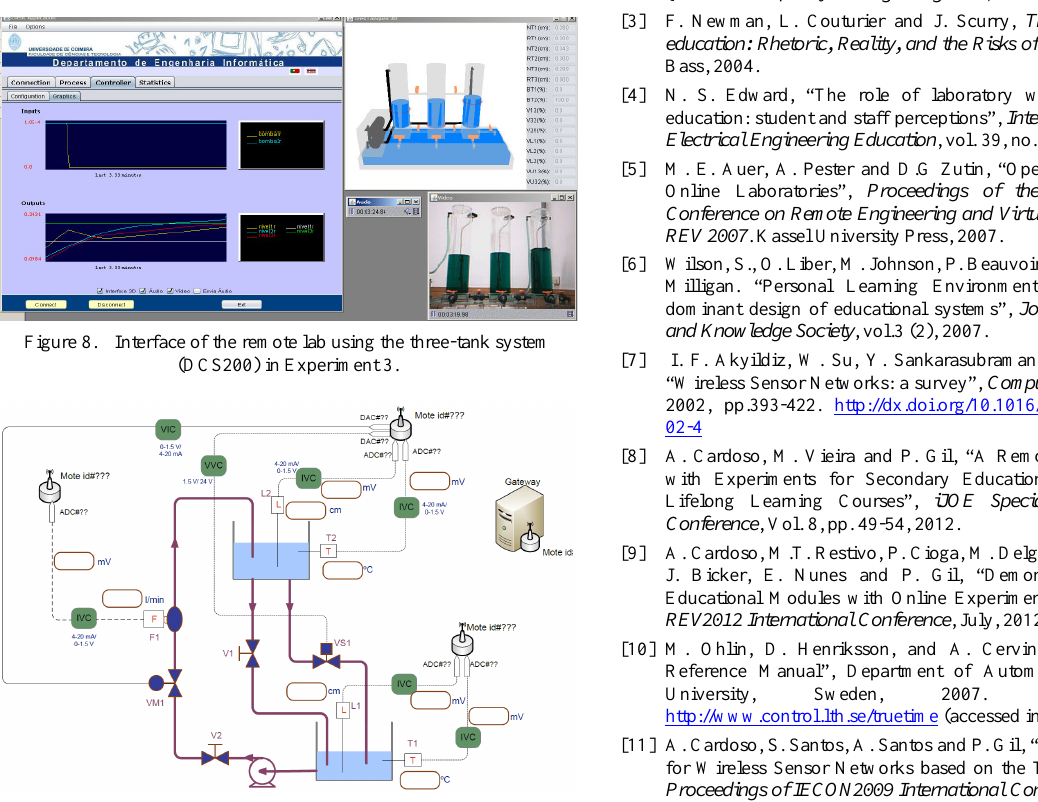
Figure 9. The diagram of the Distributed Control System based on a WSAN used in Experiment